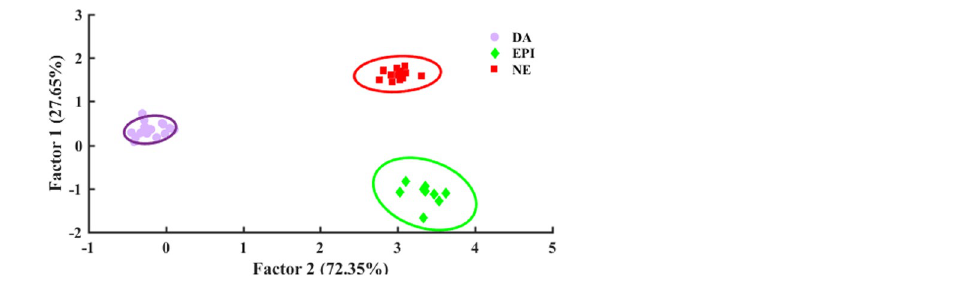
Figure 6. LDA score plot, urine sample was spiked with catecholamines at concentrations of 10 µ mol L − 1